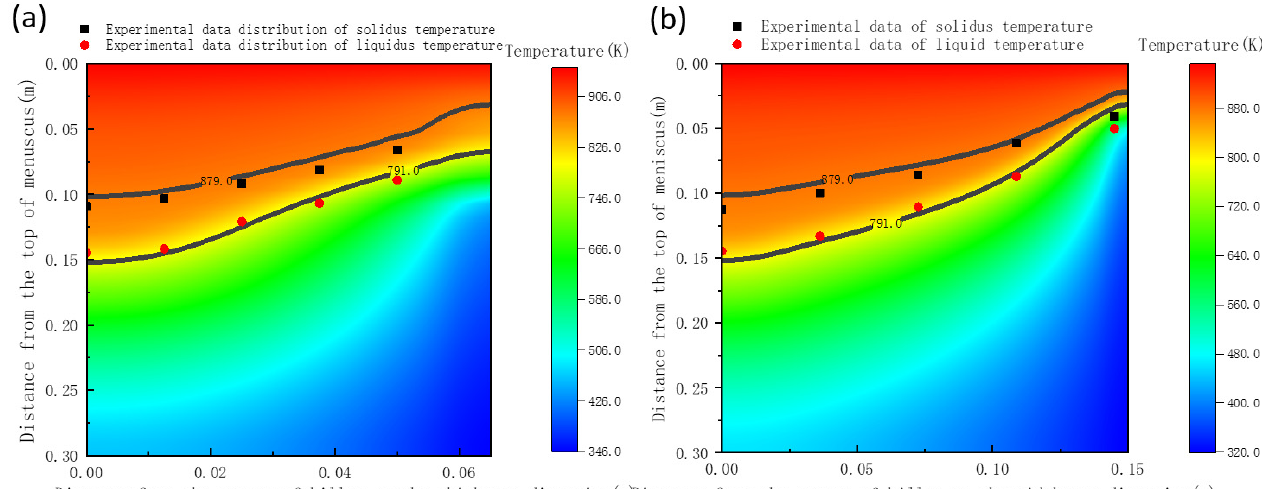
Figure 16. Comparisons between results of numerical simulation and temperature-measurement experiment: ( a ) on thickness direction at symmetry face S x ; ( b ) on width direction at symmetry face S y .